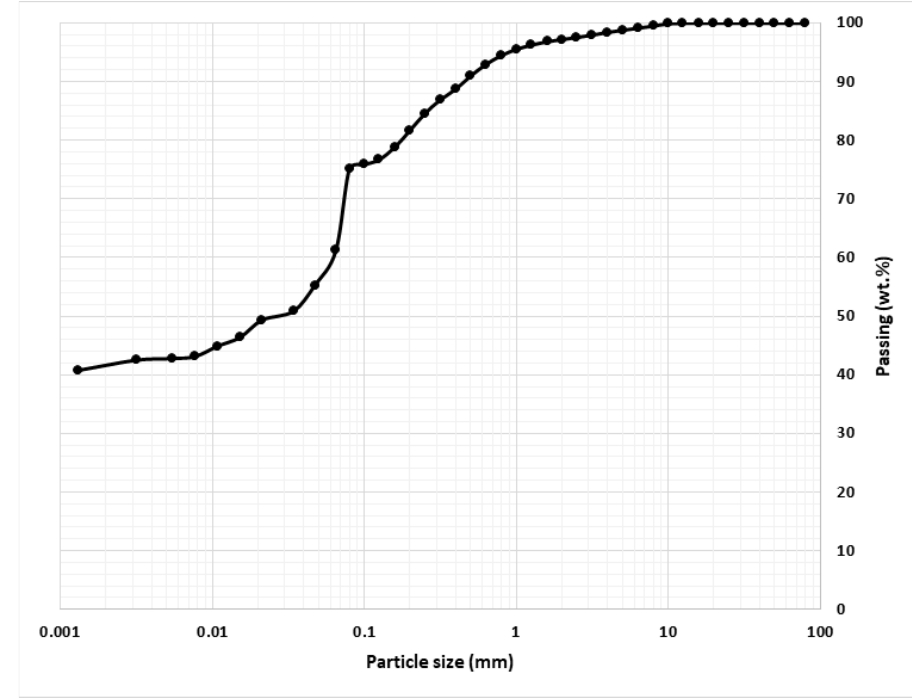
Figure 2. Particle size distribution of Louaga sample. The chemical composition of Louaga clay soil is given in Table 2. Table 2. Chemical composition of the soil used in this study (L.O.I.: loss on ignition).